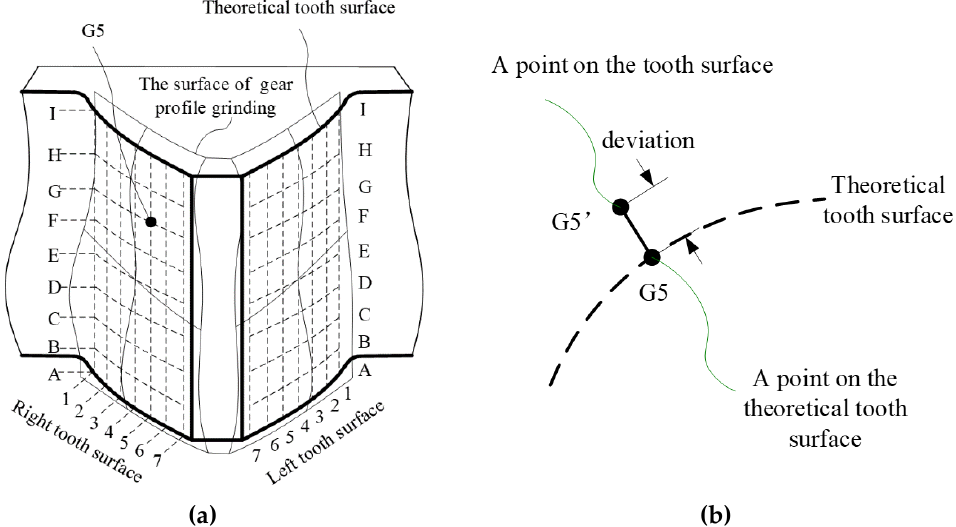
Figure 5. Deviations between the profile grinding tooth surface and the theoretical tooth surface: ( a ) the gear profile grinding surface and theoretical tooth surface; ( b ) deviation of a point on the tooth surface of gear profile grinding.